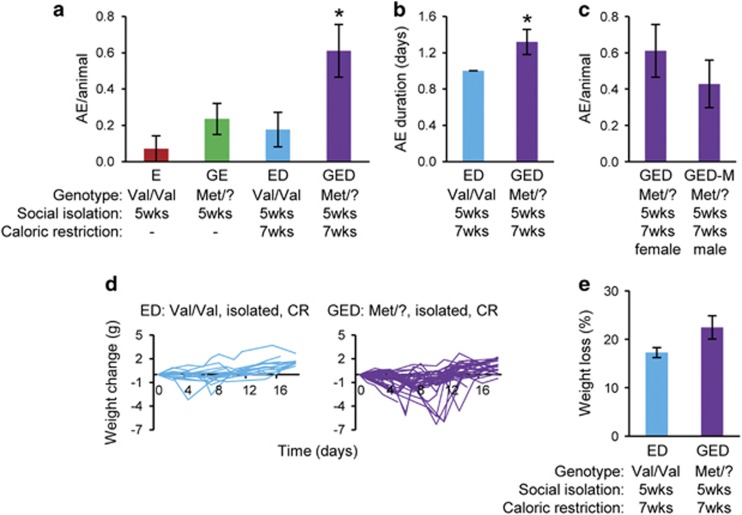
Peri-pubertal caloric restriction synergizes with genetic and environmental factors to promote abnormal feeding behavior. (a) Number of aphagic episodes (AE) per animal per group from 7 to 9.5 weeks of age in singly housed hBDNFVal/Val (E) and hBDNFMet/? (GE) females; or calorically restricted singly housed hBDNFVal/Val (ED) and hBDNFMet/? (GED) females (E, 0.07±0.07 AE per animal, n=14, 4 cohorts; GE, 0.23±0.08 AE per animal, n=34, 9 cohorts; ED, 0.18±0.95 AE per animal, n=17, 6 cohorts; GED, 0.61±0.14 AE per animal, n=36, 6 cohorts). *P<0.05, ANOVA. (b) Duration of AEs in ED and GED groups (ED, 1day, n=2; GED, 1.3±0.1 days, n=15). *P<0.05, Student's t-test. (c) Number of AE per animal per group triggered by caloric restriction in singly housed hBDNFMet/? females (GED) and males (GED-M) (GED, 0.61±0.14 AE per animal, n=36, 6 cohorts; GED-M, 0.43±0.13 AE per animal, n=21, 3 cohorts). P<0.05, Student's t-test. (d) Body weight changes within respective groups, each line represents one animal. Time 0 day starts at 7 weeks. (ED, n=17; GED, n=36). (e) Body weight loss in ED and GED groups during AEs (ED, 17.2±1.5 g, n=2; GED 22.5±6.3 g, n=7) P<0.05, Student's t-test. Error bars denote s.e.m. ANOVA, analysis of variance; D, dietary stressor; E, environmental stressor; GE, genetic susceptibility and environmental stressor.